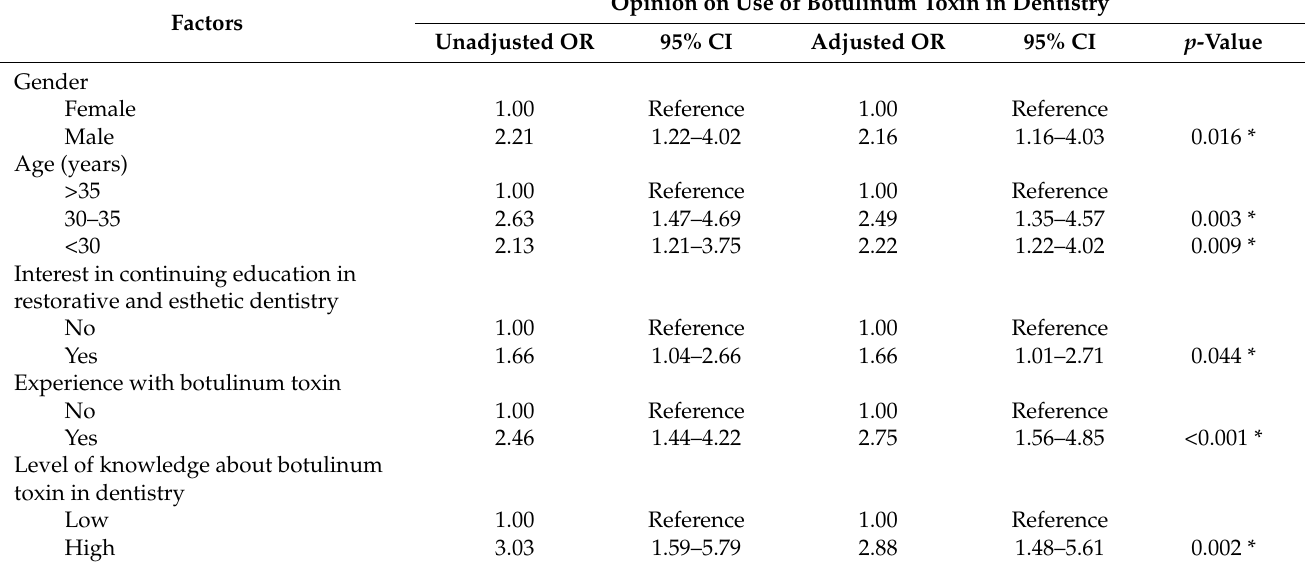
Table 4. Multivariate logistic regression analysis of factors associated with opinion on the use of botulinum toxin in dental patients ( n =